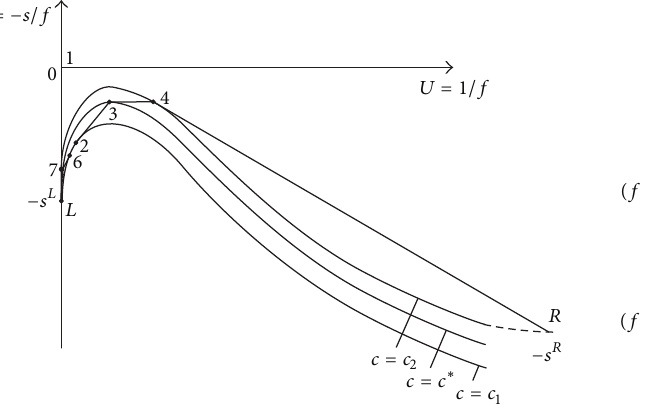
Figure 7: The image of the solution in ( 𝐹 - 𝑈 ) plane.